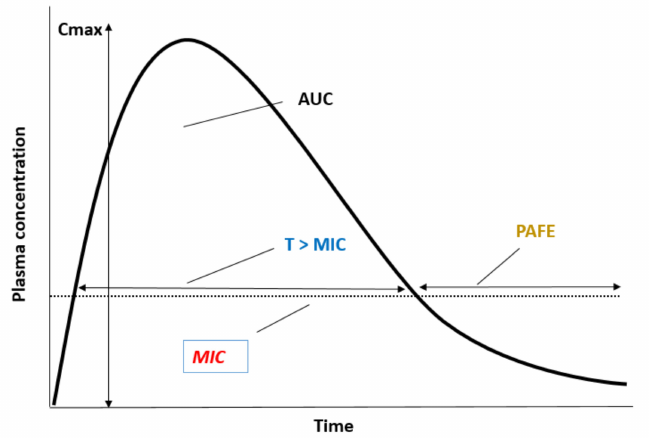
Figure 3. The maximal concentration (C max ), the ratio of drug area under the concentration–time curve (AUC) to MIC (dotted line) over a 24 h period (AUC 0–24h /MIC) or the time (expressed as a percentage of the dosing interval) that drug concentrations are expected to exceed the MIC (%T > MIC) as PK/PD index that link the kinetics of antifungal disposition, MIC and PAFE values with the antifungal clinical